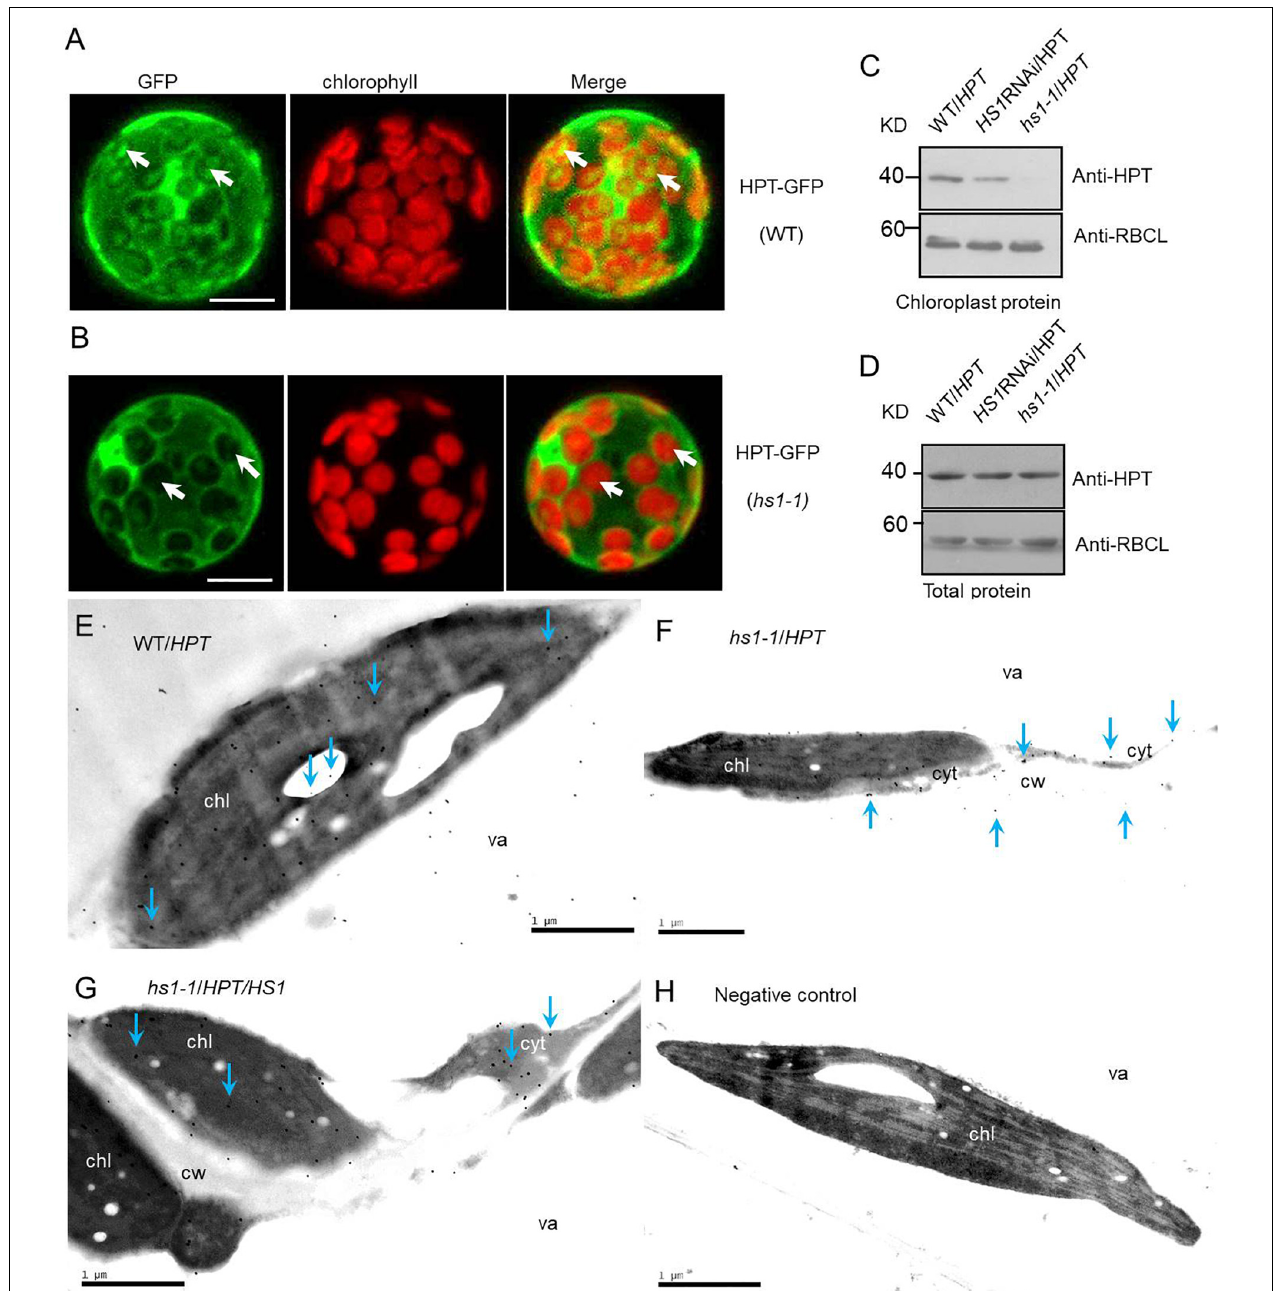
FIGURE 3 | HS1 is involved in cytosol-to-chloroplast transport of HPT. Subcellular localization of HPT-GFP in the WT (A) and hs1-1 (B) backgrounds in Arabidopsis. HPT-GFP constructs were transformed transiently into plant cells. Arrowheads indicate higher chloroplast GFP fluorescence intensity in a mesophyll protoplast of WT compared to hs1-1 . Bars = 10 µ m. (C , D) Western blot of HPT in WT/ HPT (empty vector transgenic lines), HS1 RNAi/ HPT , and hs1-1 / HPT (empty vector transformed into hs1-1 ) transgenic plants. HPT accumulation was reduced significantly or undetectable in HS1 RNAi/ HPT and hs1-1/HPT chloroplasts compared with the control (C) , while total HPT varied slightly (D) . The large subunit of RUBISCO (RBCL) was probed as a protein loading control. Approximately 20 µ g (C) and 10 µ g (D) of protein were loaded in each lane. Similar results were obtained in two additional independent experiments. (E–H) Transmission electron microscopic images of immunogold localization of HPT in transgenic Arabidopsis . HPT in ultrathin leaf sections reacted with anti-HPT antibody and a gold-conjugated secondary antibody. Gold particles were detected by transmission electron microscopy. Immunogold labeling of HPT in leaves from WT/ HPT (E) , hs1-1 / HPT (F) , hs1-1 / HPT / HS1 (G) , negative control (H) transgenic Arabidopsis plants, and negative control without anti-HPT antibody in blocking buffer showed no gold particles. Arrowheads show typical gold particles (10 nm, black dots). HPT present inside of chloroplasts (chl, the dark area) in WT / HPT , hs1-1 / HPT / HS1 , and outside of chloroplasts in hs1-1 / HPT . Three different leaf samples and more than 30 immunogold-labeled positive cells were observed with similar results. Images represent typical observations in different leaf samples. chl, chloroplast; cyt, cytosol; va, vacuole; cw, cell wall. Bars = 1 µ m.